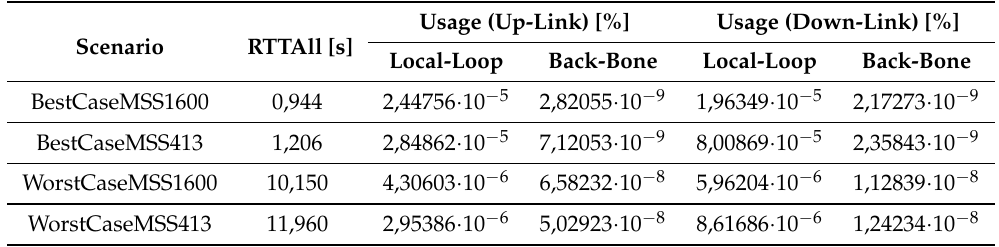
Table A2. Standard deviation of the results for the different scenarios analyzed with GPRS technology (Figures 7 and 8).